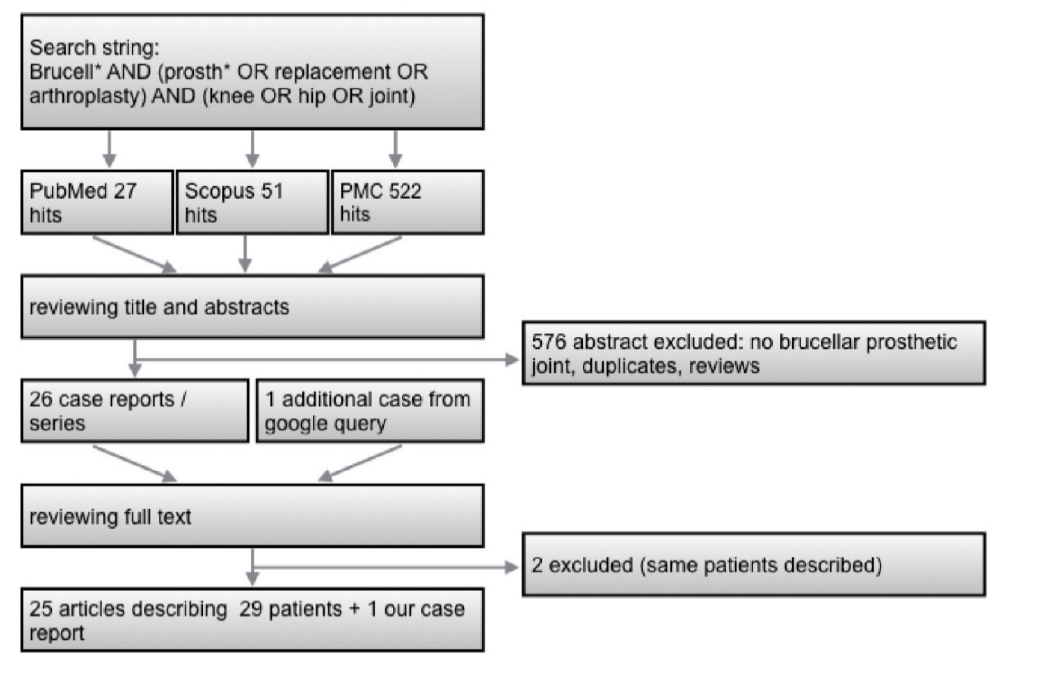
Figure 2. Flow-chart for literature